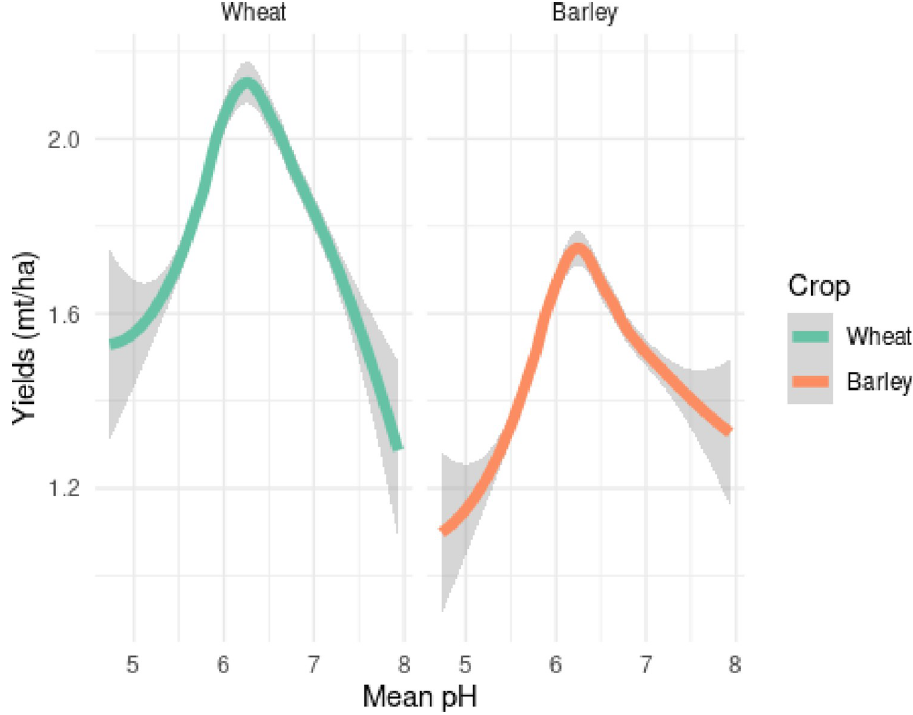
Fig 2. Bivariate relationship between crops yields and soil